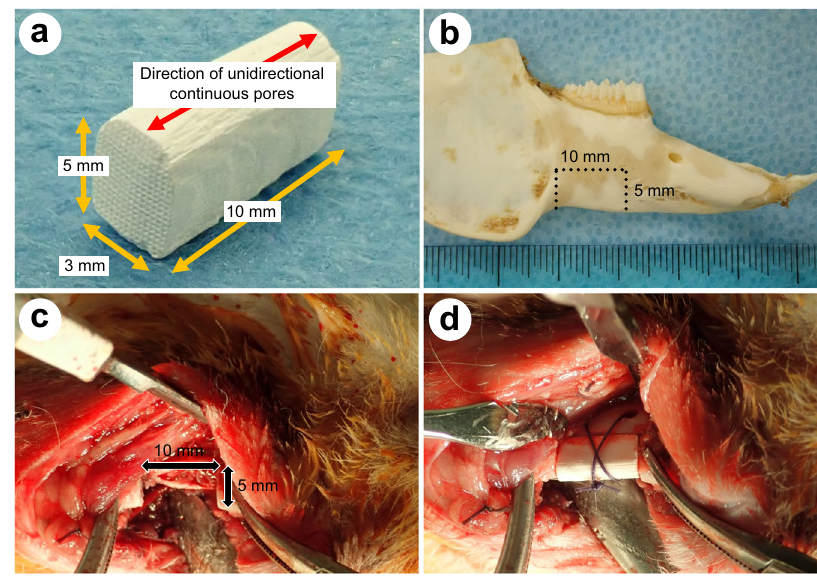
Fig. 1 Application of the CO 3 Ap HCBs for reconstruction of the rabbit mandibular bone defects.